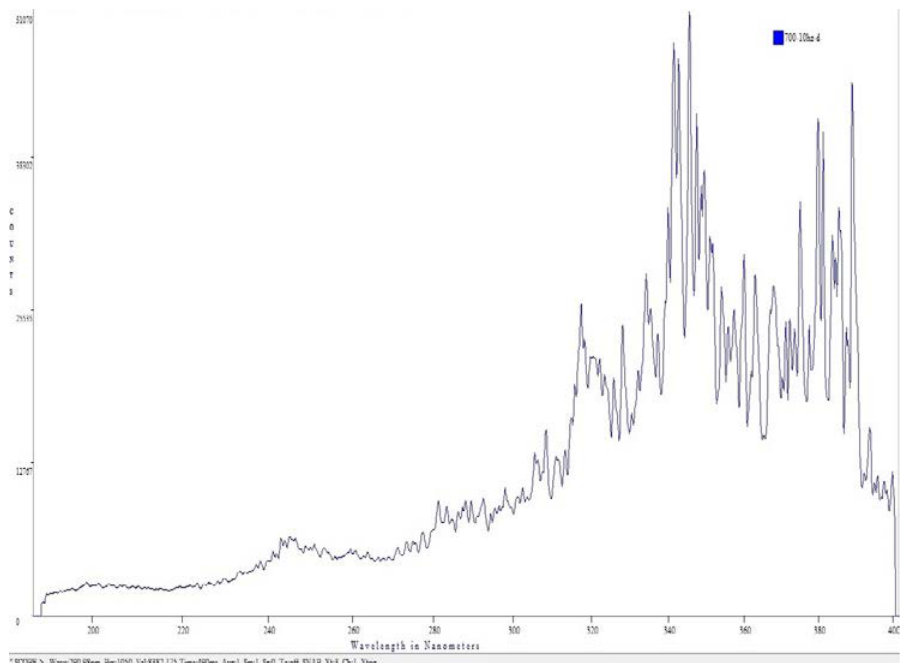
Fig.10: Emission spectra of laser energy 700 mJ with 10Hz repetition rate